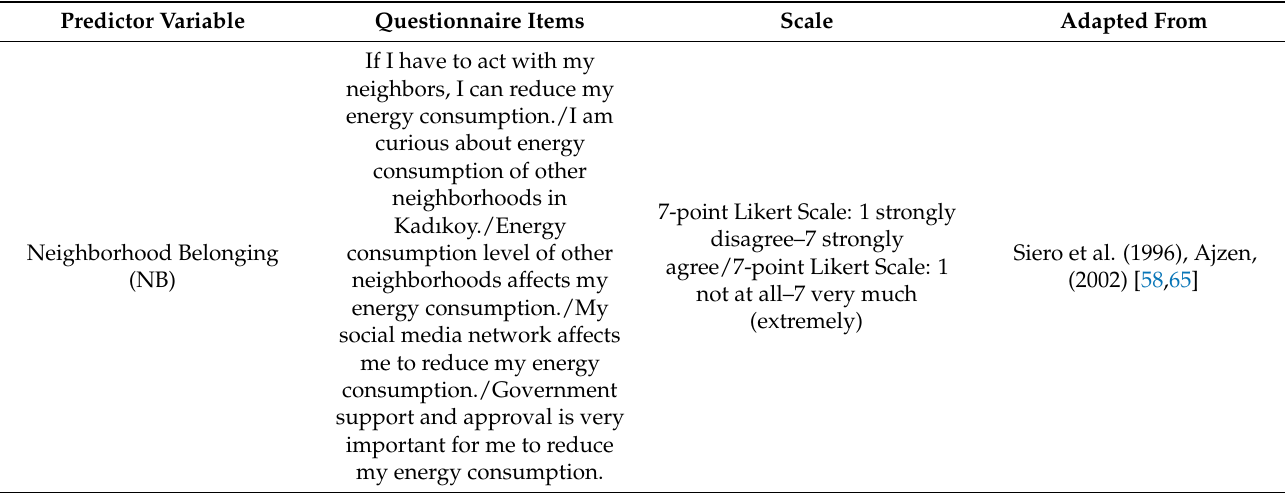
Table 6. Neighborhood Belonging (the table was created by using resource of Ajzen and Fishbein, 2005